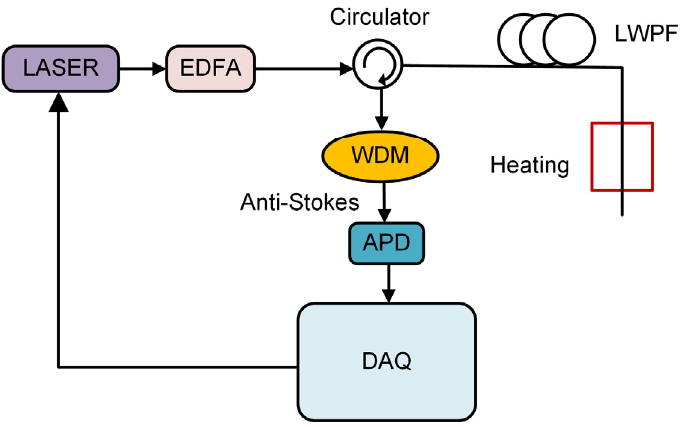
Figure 1. LWPF-based RDTS setup.